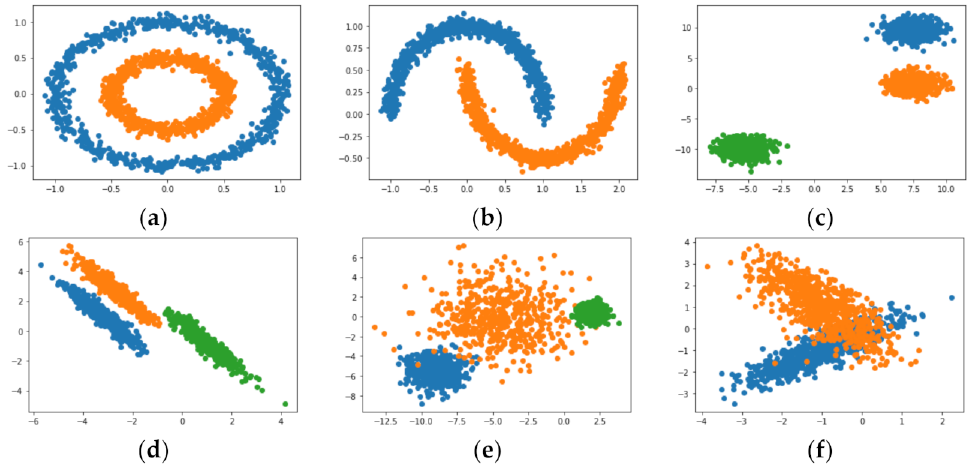
Figure 5. Used datasets: ( a ) noisy circles, ( b ) noisy moons, ( c ) blobs, ( d ) anisotropically distributed data, ( e ) blobs with varied variances, and ( f ) overlapped distributed datasets.